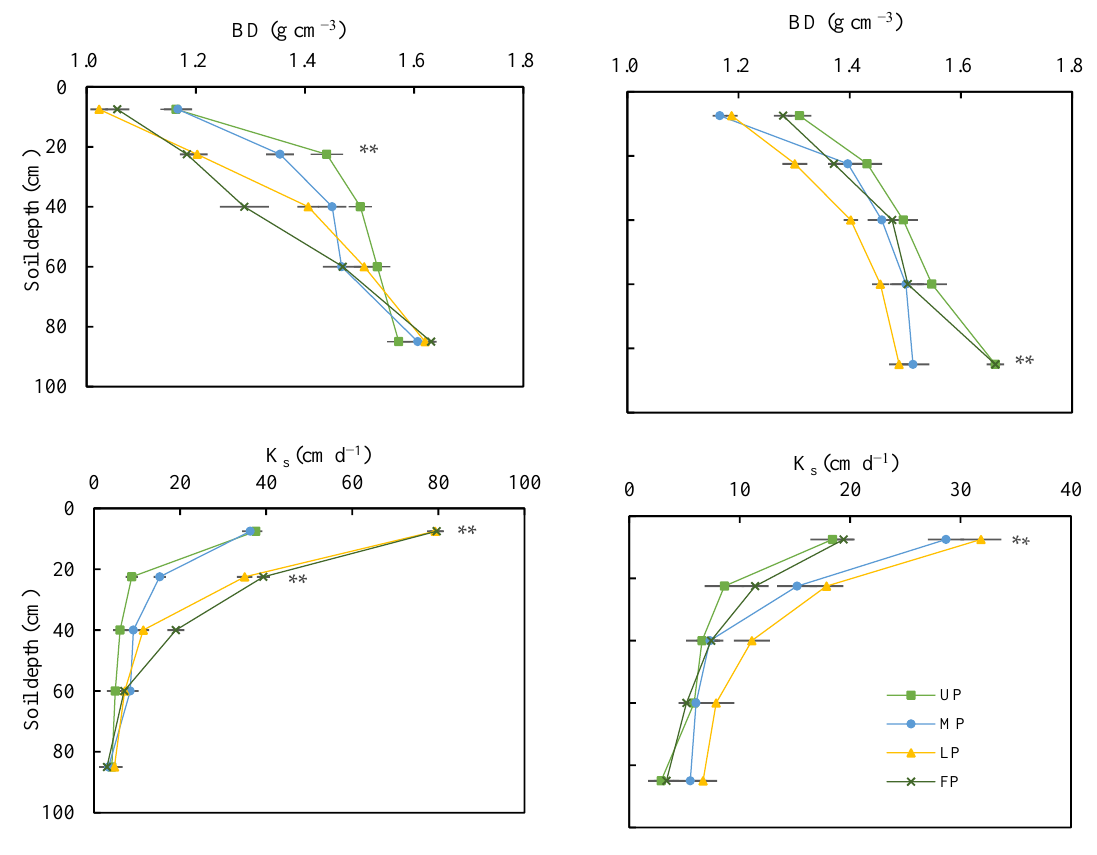
slope positions. However, K s was greater at the footslope position than that at the upper slope position while lower than those at the middle slope and lower slope positions (Fig- ure 2). When averaged across the slope positions, soil bulk density increased 0.13 g cm −3 ( p = 0.002) and K s decreased 15.85 cm d −1 ( p = 0.01) in conventional cropland compared with sustainable cropland at 0 – 15 cm depth. With increasing soil depth in both conven- positions were higher but the silt + clay fraction was lower in the sustainable cropland than tional cropland and sustainable cropland, soil bulk density significantly increased, and in the conventional cropland (2.68% in LMA, 66.11% in SMA, 19.38% in MI, 11.75% in SC vs. the increase was recorded along the soil profiles (0 – 100 cm), but K s decreased and the 2.62%, 65.87%, 19.15%, 12.36%, respectively) (Figure 3). However, the difference between decrease mainly occurred at 0 – 50 cm depth (Figure 2). the conventional cropland and sustainable cropland was not statistically significant.